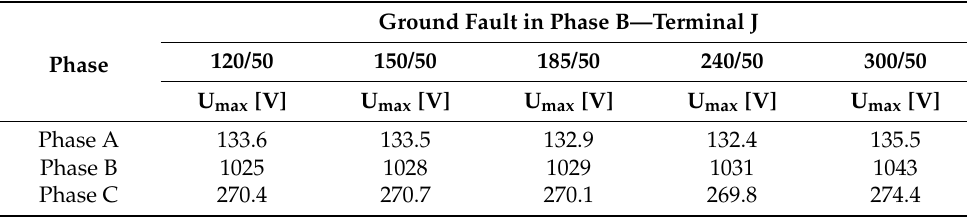
Table 6. Maximum overvoltages for different cross-sections of conductors.